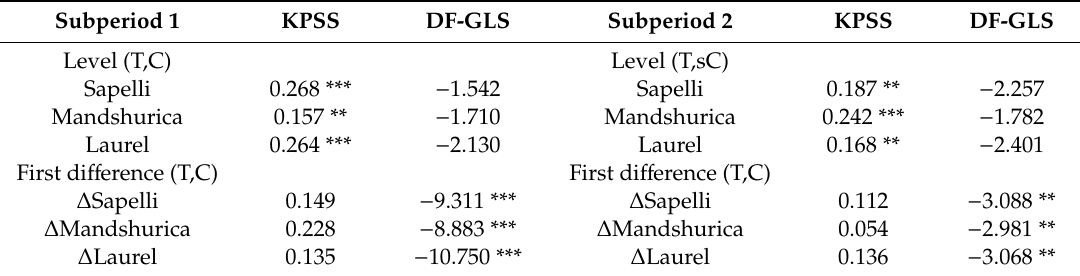
Table 2. Unit root test results.